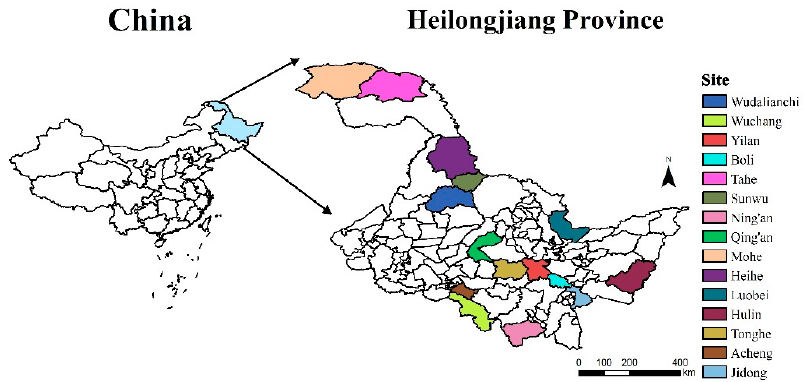
Figure 1. Geographical position of study area and sampling plots in Heilongjiang province.